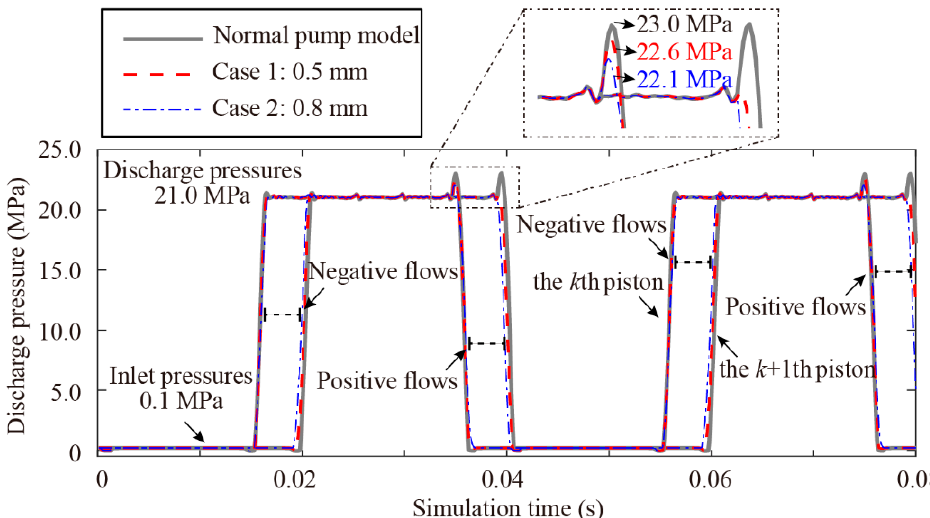
Figure 10. Internal pressures of the kth piston and the k + 1th piston.